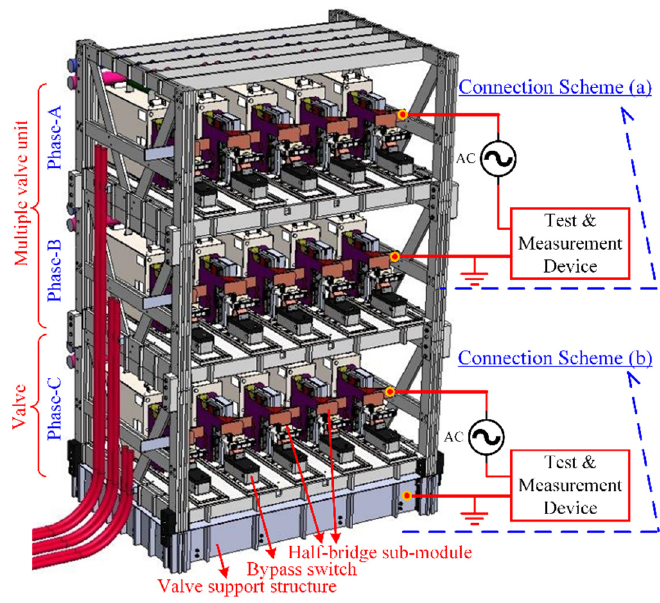
Figure 4. Connection schemes of test and measurement system for the HVDC prototype system.